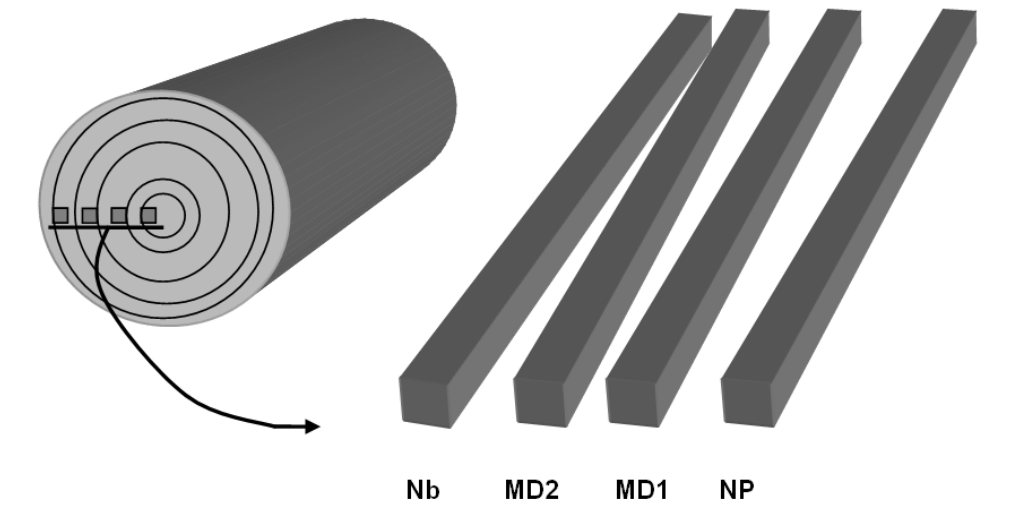
Fig. 1. Four locations from pith to bark [specimens dimensions: 2*2*36 cm